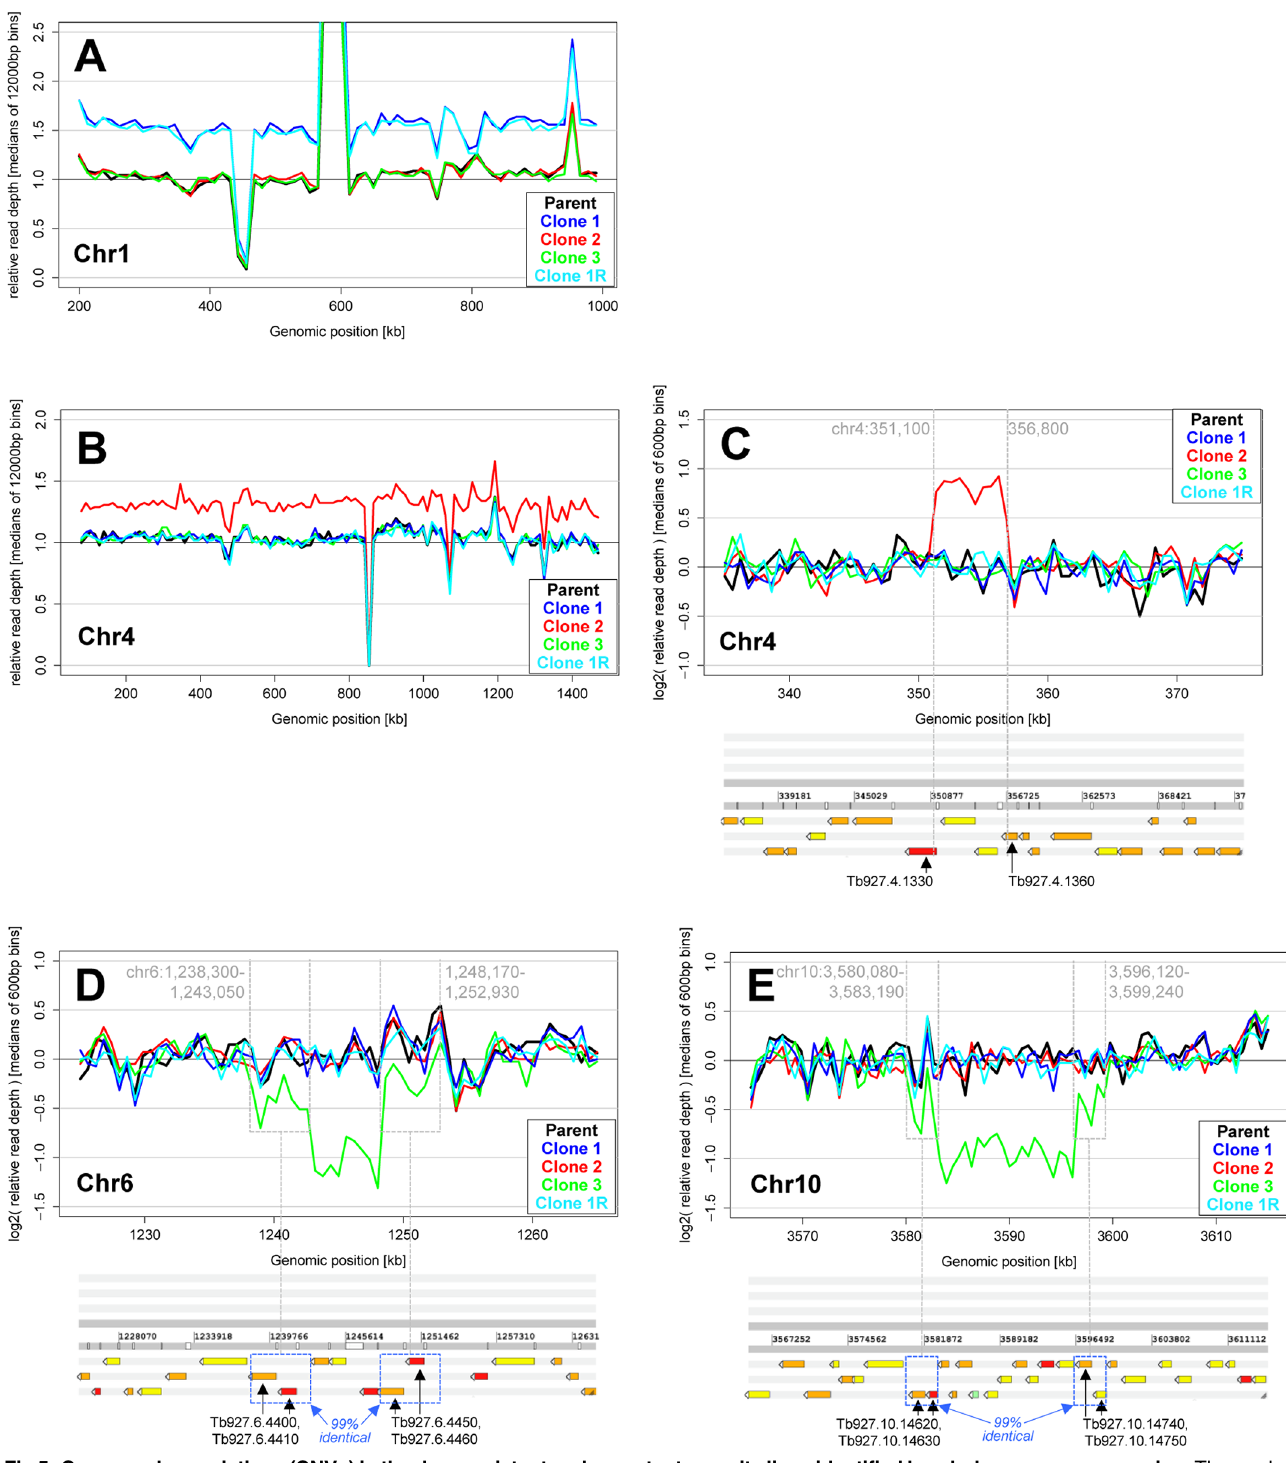
Fig 5. Copy number variations (CNVs) in the drug-resistant and -revertant parasite lines identified by whole genome sequencing. The read coverage plots show the relative read depth across selected chromosomal regions in the different parasite lines. ( A, B ) The panels depict the relative read coverage across the core regions of chromosomes 1 and 4, analysed in windows of 12 kb width, by plotting the ratio of the median read depth observed in a given window over the median read depth of all chromosomes for that parasite line. A relative read depth of 1.5 therefore represents a 50% copy number increase of the respective chromosome compared to the rest of the genome, which indicates an absolute copy number increase from two to three in the